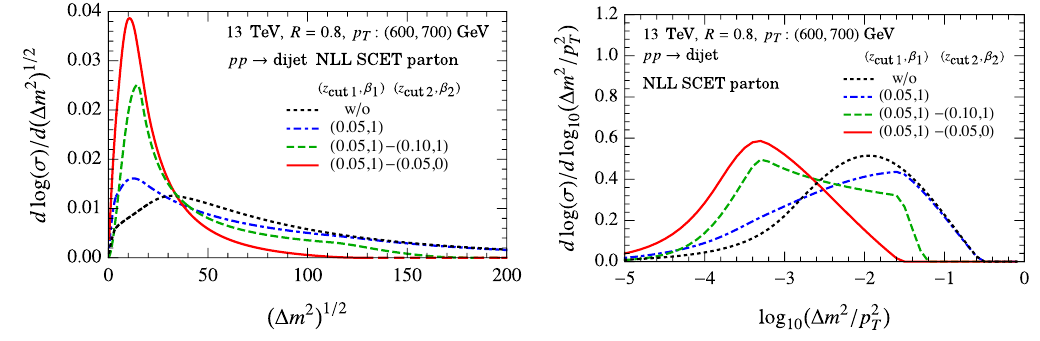
Figure 9 . Comparison of collinear drop, soft drop, and ungroomed jet mass spectra calculated using SCET. The soft drop parameters are z cut1 = 0 : 05 and (cid:12) 1 = 1 in all cases, while the collinear drop parameters are varied as indicated. The left and right panels show the same spectra but plotted with di(cid:11)erent axes choices in order to contrast the linear versus logarithmic distributions.